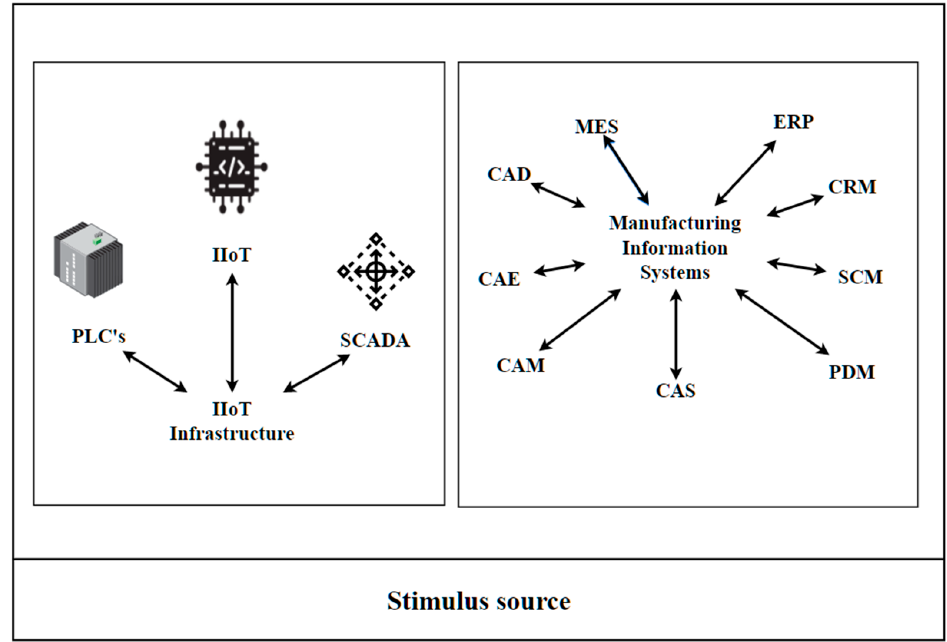
Figure 5. Stimulus source for the main attribute scenarios. (Graphics source: https://online.visual- paradigm.com /, accessed date: 14 June 2021).